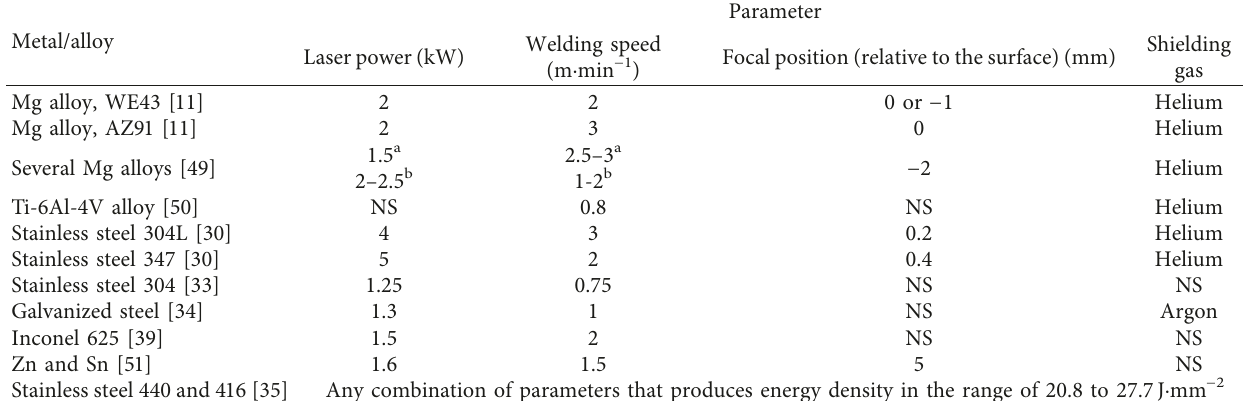
Table 2: Optimum laser welding parameters for a selection of metals and